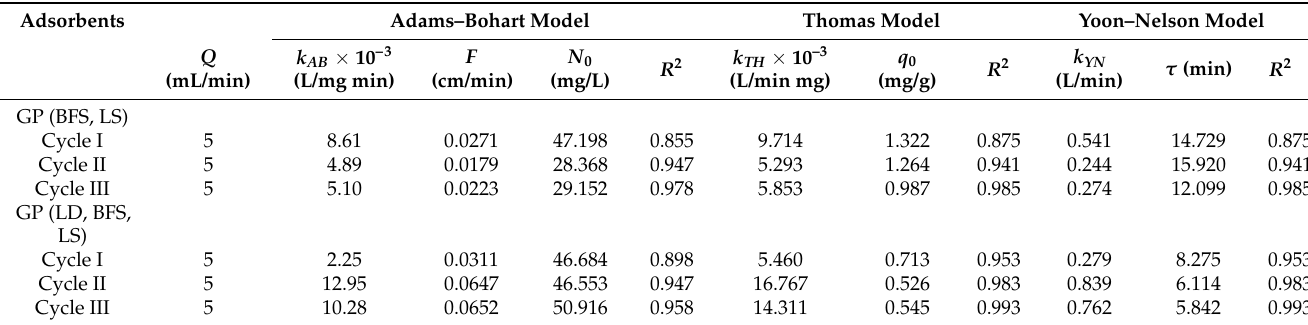
Table 4. Parameters of the Adams–Bohart, Thomas, and Yoon–Nelson models for nickel(II) adsorption by slag-based geopolymers GP (BFS, LS) and GP (LD, BFS, LS) cycles at a fixed-bed height, concentration, and flow rate. Adsorbents Adams–Bohart Model Thomas Model Yoon–Nelson